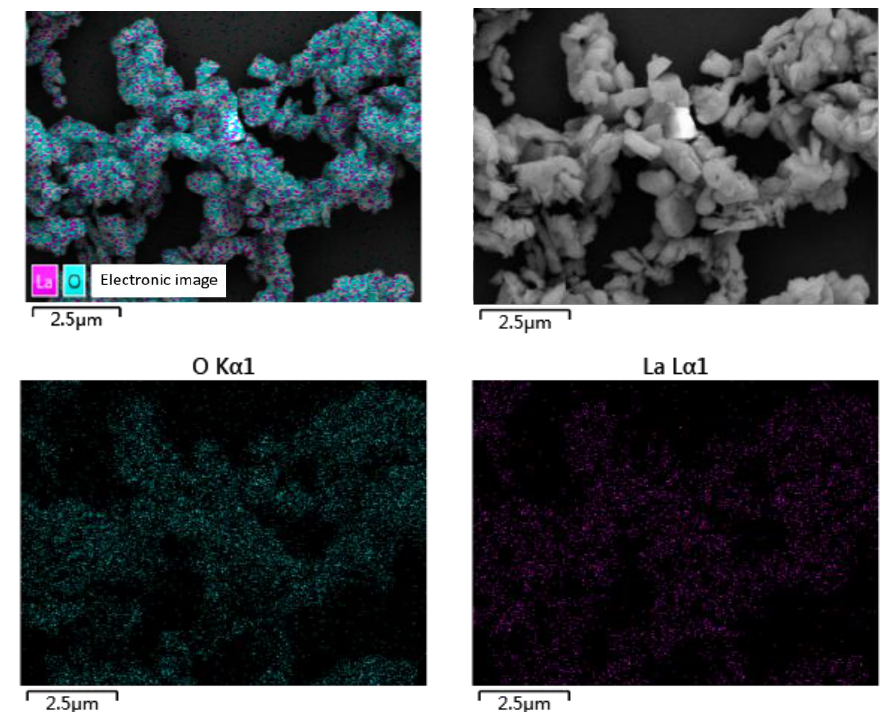
Figure 1. Scanning electron microscope (SEM) micrograph of selected La 2 O 3 .